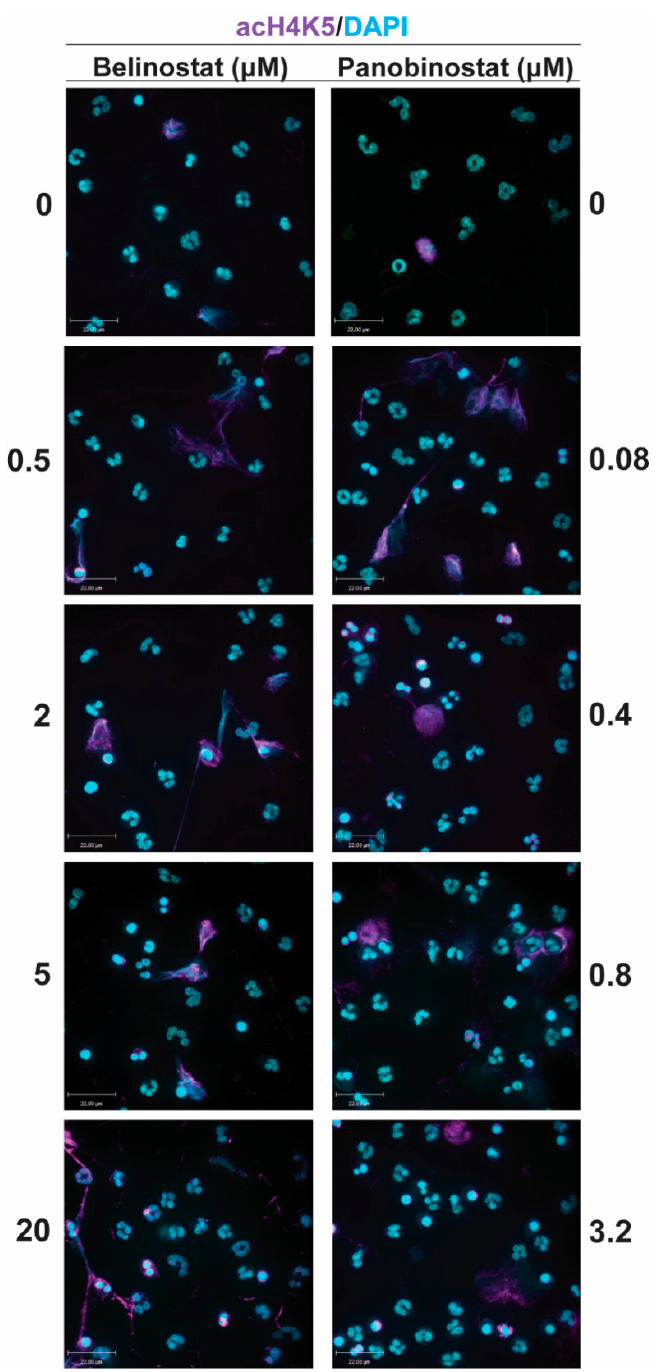
Figure 1. Confocal microscopy images showing histone deacetylase (HDAC) inhibitors promote histone acetylation. Neutrophils were treated with negative control (Roswell Park Memorial Institute (RPMI) media) or HDACis (0.5, 2, 5 and 20 µM belinostat; 0.08, 0.4, 0.8 and 3.2 µM panobinostat) for 120 min. Cells were then imaged after being fixed and immunostained for histone acetylation (H4K5ac) and DNA (4 ′ ,6-diamidino-2-phenylindole, DAPI). Neutrophils treated with RPMI show typical polymorphonuclear morphology of neutrophils. When treated with HDACis, neutrophils show a further increase in histone acetylation. Blue, DAPI staining for DNA; Magenta, H4K5ac. Scale bar, 14 µ m. n = 3. See Supplementary Figure S1 for colocalization data between DAPI and AcH4. To confirm the results of our immunofluorescence imaging, we performed Western blots and checked for H4K5ac (AcH4). Results showed negligible levels of histone acetylation for neutrophils treated with RPMI (Figure 2; see Supplementary Figure S2 for uncropped Western blots). However,